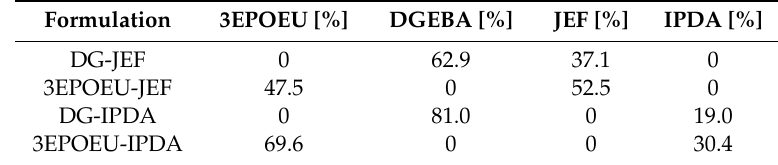
Table 1. Weight percentages of epoxy monomers and amines used in the curing formulations.